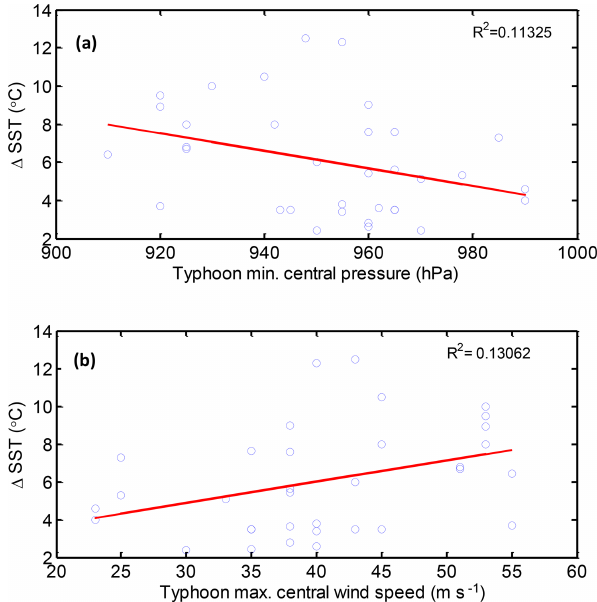
Figure 5. The correlation of (cid:49) SST with two typhoon intensity in- dicators, (a) min central pressure and (b) max wind